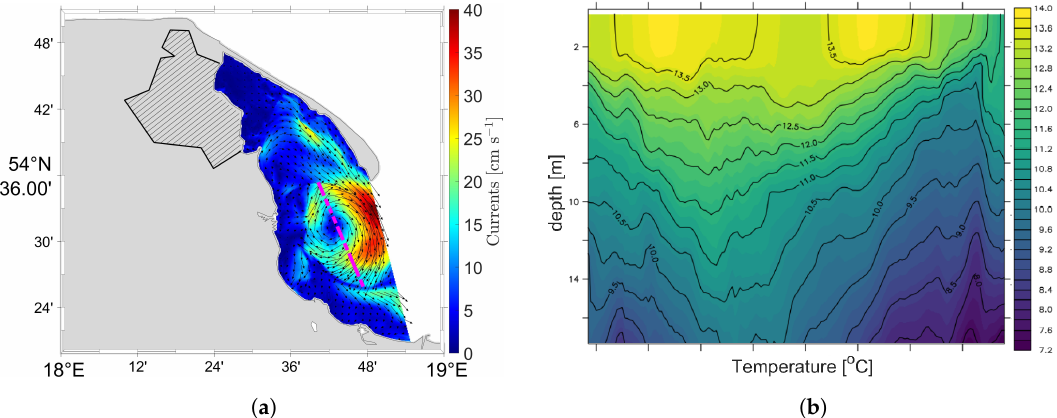
Figure 15. Surface currents distribution of anticyclone on 24 May 2018 ( a ) with marked (dashed purple) line of vertical cross-section of water temperature ( b